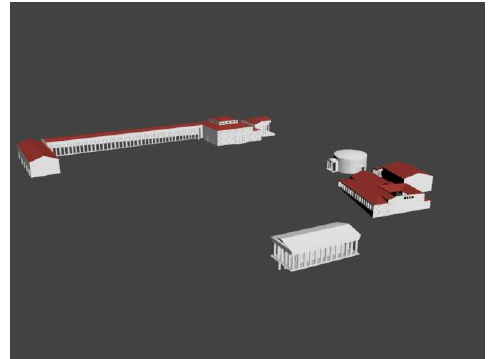
Figure 10: 3D models from 3D Warehouse library